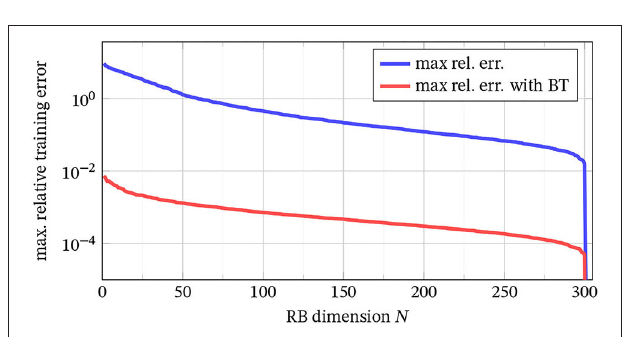
FIGURE 6 | Maximal RBM relative error decay over the reduced dimension N for the full system eq. (5.1a) (blue) and the reduced system eq. (5.2a) with K = 300